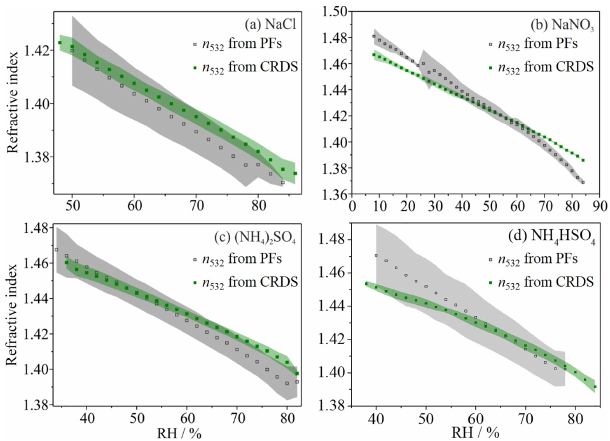
Figure 6. Comparison of n 532 values determined from either PFs recorded using BB illumination or σ ext data using 532nm SP- CRDS. The shaded envelopes represent 1 standard deviation in the measurements.